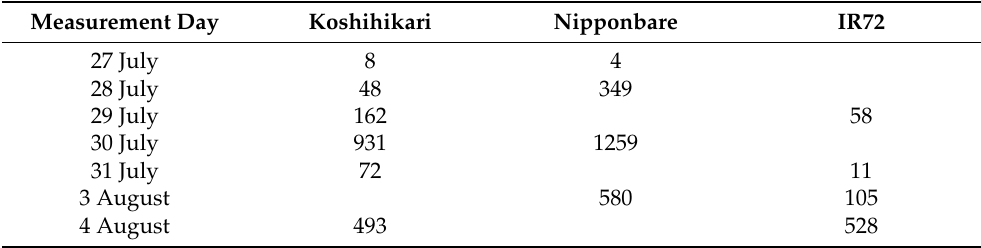
Table 1. Range of maximum emission rates of linalool observed after enclosing rice leaves and stems with the enclosure bag.